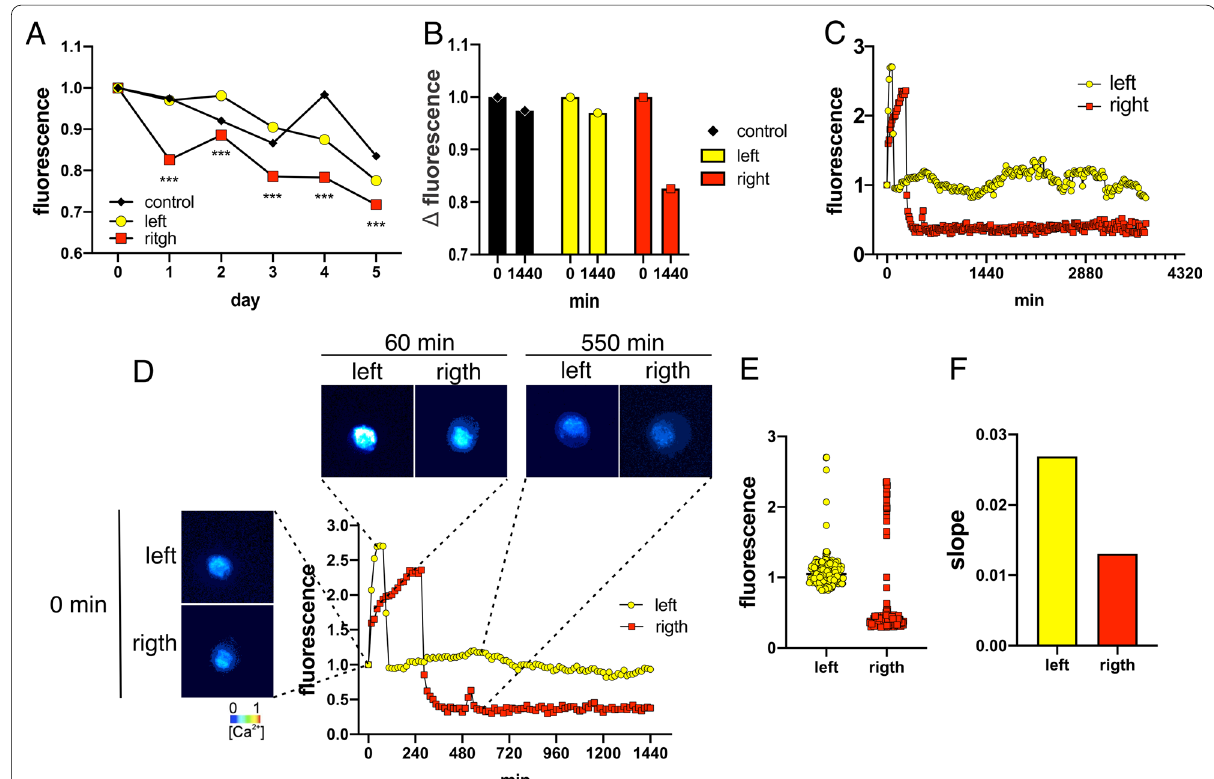
Fig. 4 Calcium dynamics in MDA-MB231 cells treated with L- and R-extracts. A Mean of intracellular Fluo-3 fluorescence measured day-by-day in a Nikon TE300 Inverted Fluorescence Phase Contrast Microscope, in L, R and Control conditions. Still Images of cohorts of 15–75 cells per condition were analyzed with Microsoft Excel and Image J (National Institutes of Health, USA, RRID:SCR_003070) during 5 days. Fluorescence data was calculated as mean/area. As can be observed, in the R-treated cells intracellular Ca 2 + concentration decreases at day 1, (as compared to controls and to L-treated cells) and this difference is maintained along the 5 days (Kruskal–Wallis test for: L/R differences: p < 0.0001;Control/R differences: p < 0.001, indicated by asterisks). While L-treated cells, despite some fluctuations during days 2–3–4, do not significantly change from the untreated cells (Kruskal–Wallis test: Control/L differences: day 1, 2, 3 and 5: ns, day 4 p < 0.01). B The Δ fluorescence of A (initial fluorescence fluorescence) was measured at time 0 and 1440 min (24 h). This shows how R-treated cells decreased the intracellular Ca 2 + concentration, which is not observed in the other conditions. C Representative Ca 2 + fluorescence plot in real time, of single cells in L- and R-conditions, during 3 days.